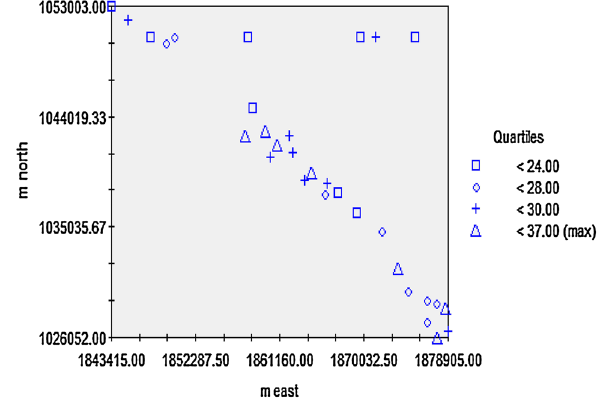
Fig. 2 Determining each well in the sampling